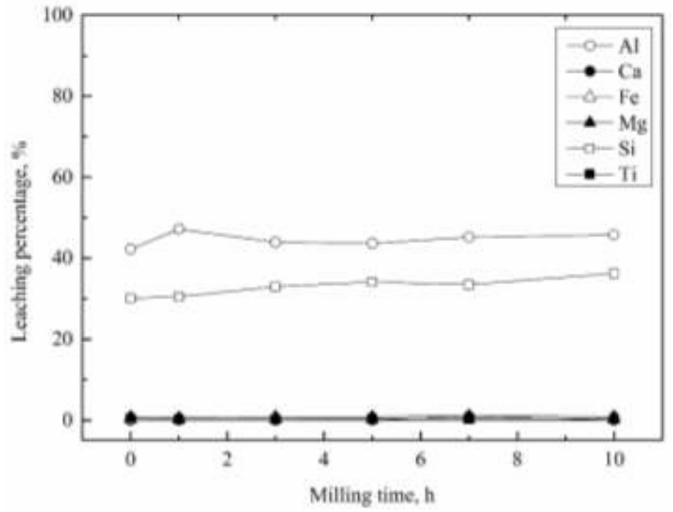
Figure 3. The effect of milling time on the leaching of the oxides from the mechanically activated dross in a 5 M NaOH solution at 50 ◦ C. (stirring speed: 200 rpm, pulp density: 20